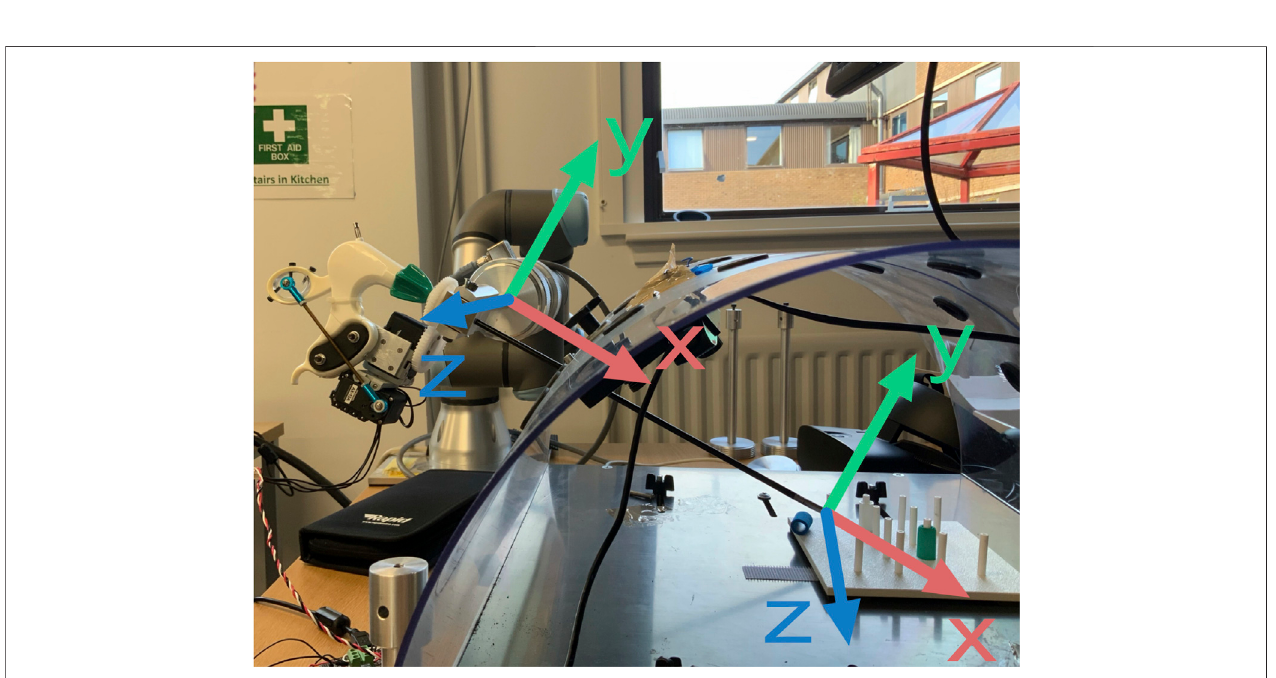
FIGURE 10 | Coordinate frame conversion from force torque sensor attached to the wrist of the robot arm to the tool-tip coordinate frame.